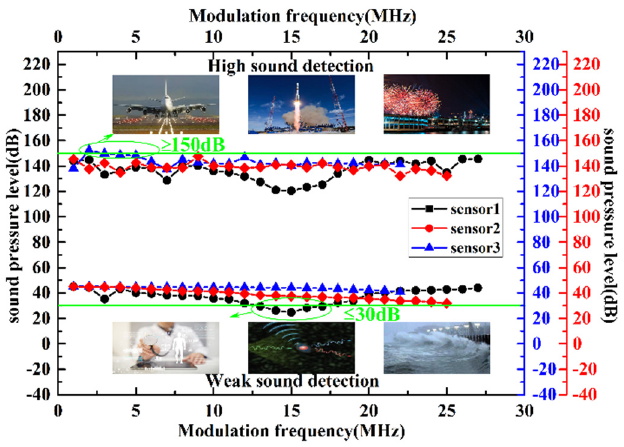
Figure 14. The maximum detectable sound pressure that can be achieved by the three FOASs.